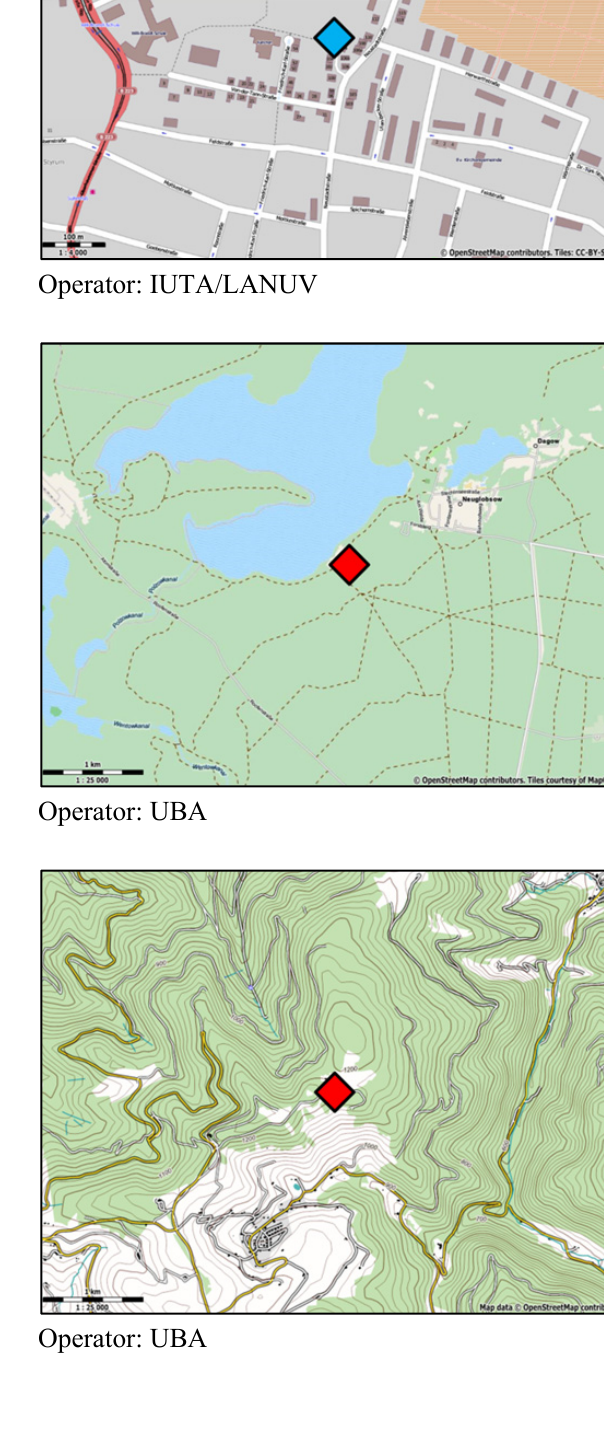
Earth Syst. Sci. Data, 8, 355–382,